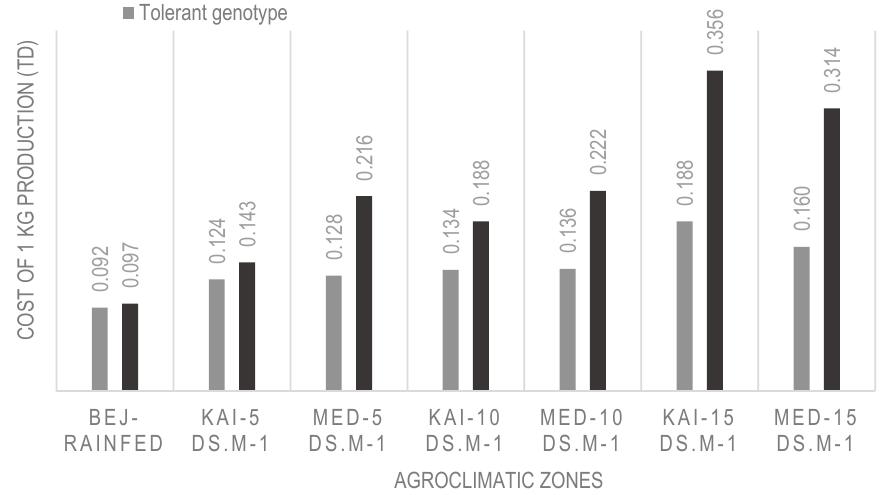
ff erent climatic